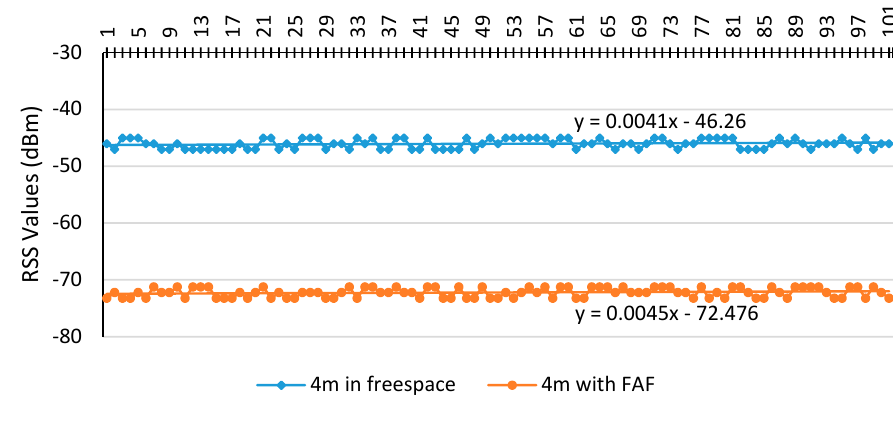
Figure 11. Floor attenuation factor (FAF) estimation.